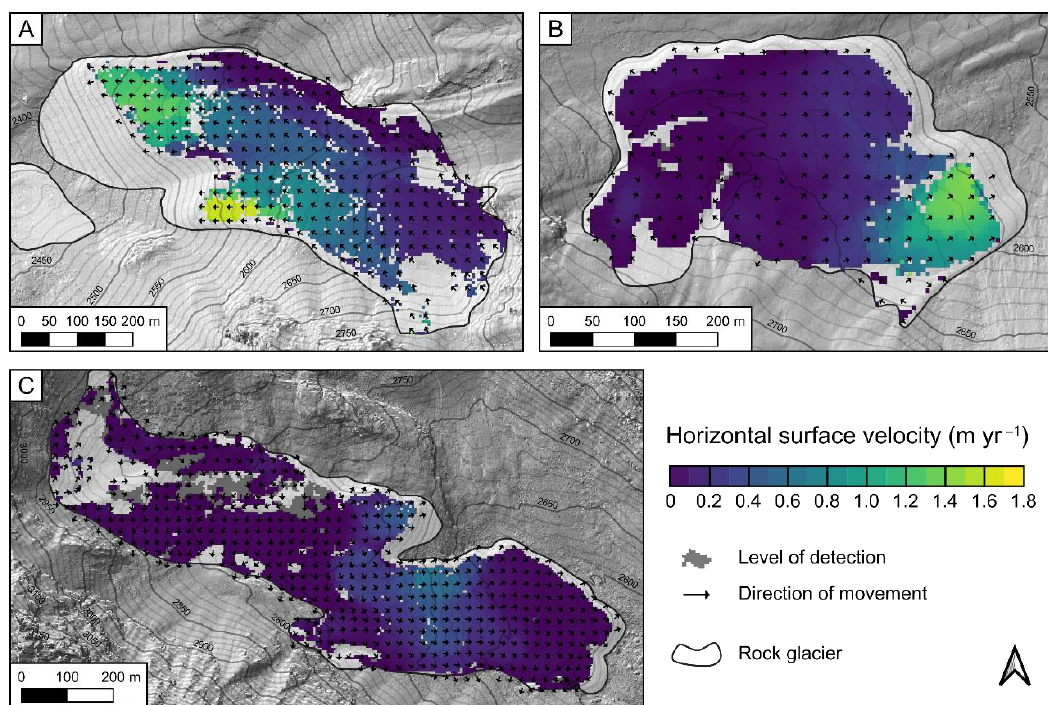
Figure 4. Horizontal surface velocity fields of selected rock glaciers: ( A ) Innere Ölgrube rock glacier (RG18), ( B ) Kaiserberg rock glacier (RG12) and ( C ) unnamed rock glacier RG14.